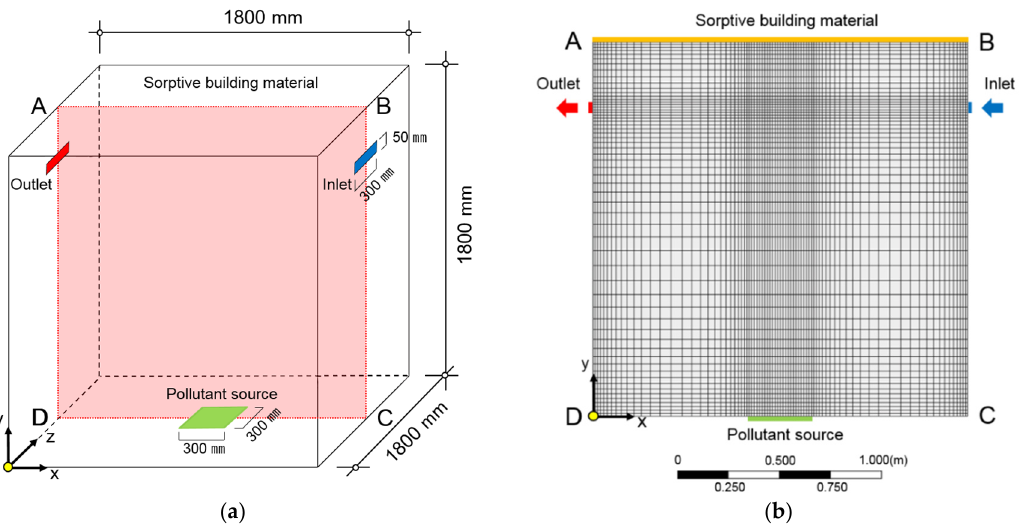
Figure 3. Model used for computational fluid dynamics (CFD) analysis: ( a ) Geometry; ( b ) Mesh (Section ABCD).